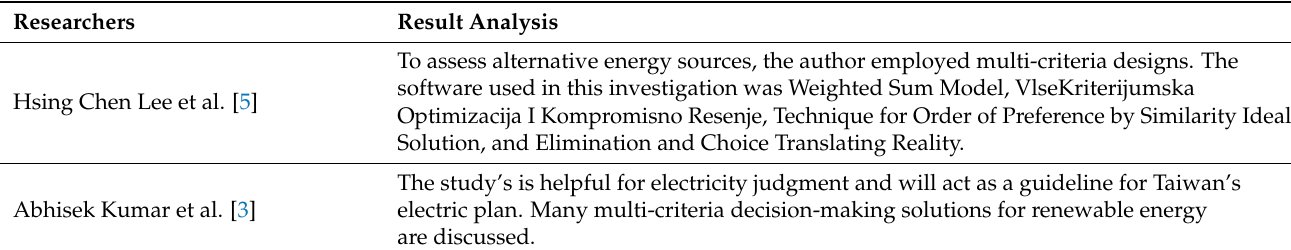
Table 1. Literature